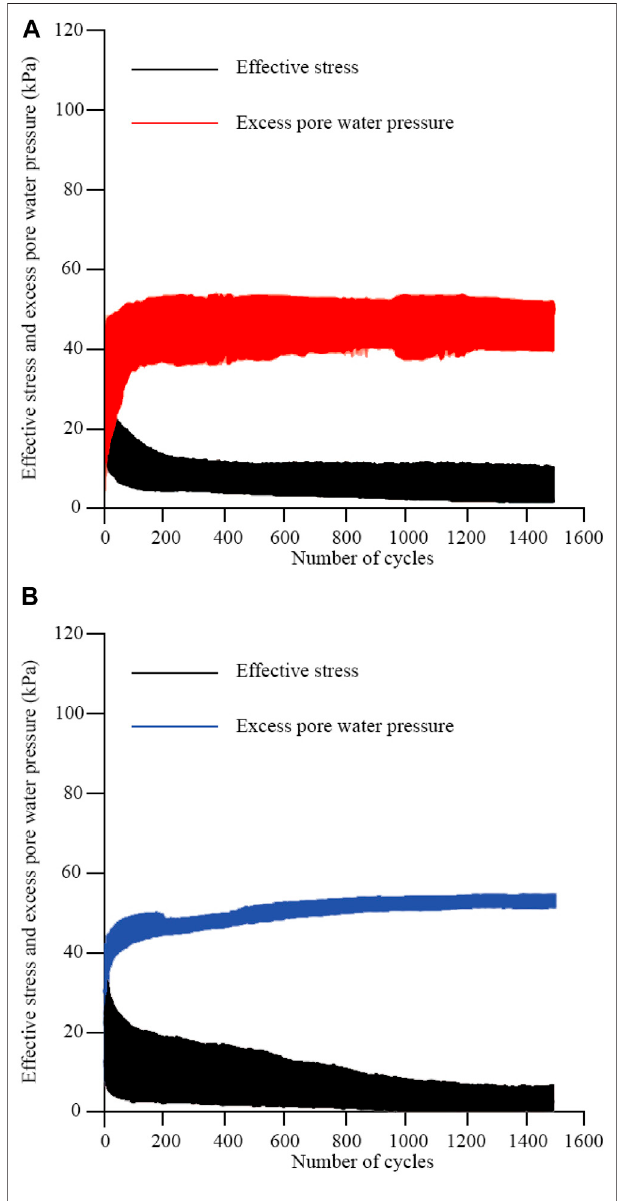
FIGURE6| Evolutionofexcessporewaterpressureand effective stress in cemented paste back fi ll under cyclic shear loading: (A) with fi ber reinforcement, and (B) without fi ber reinforcement (Festugato et al., 2013).